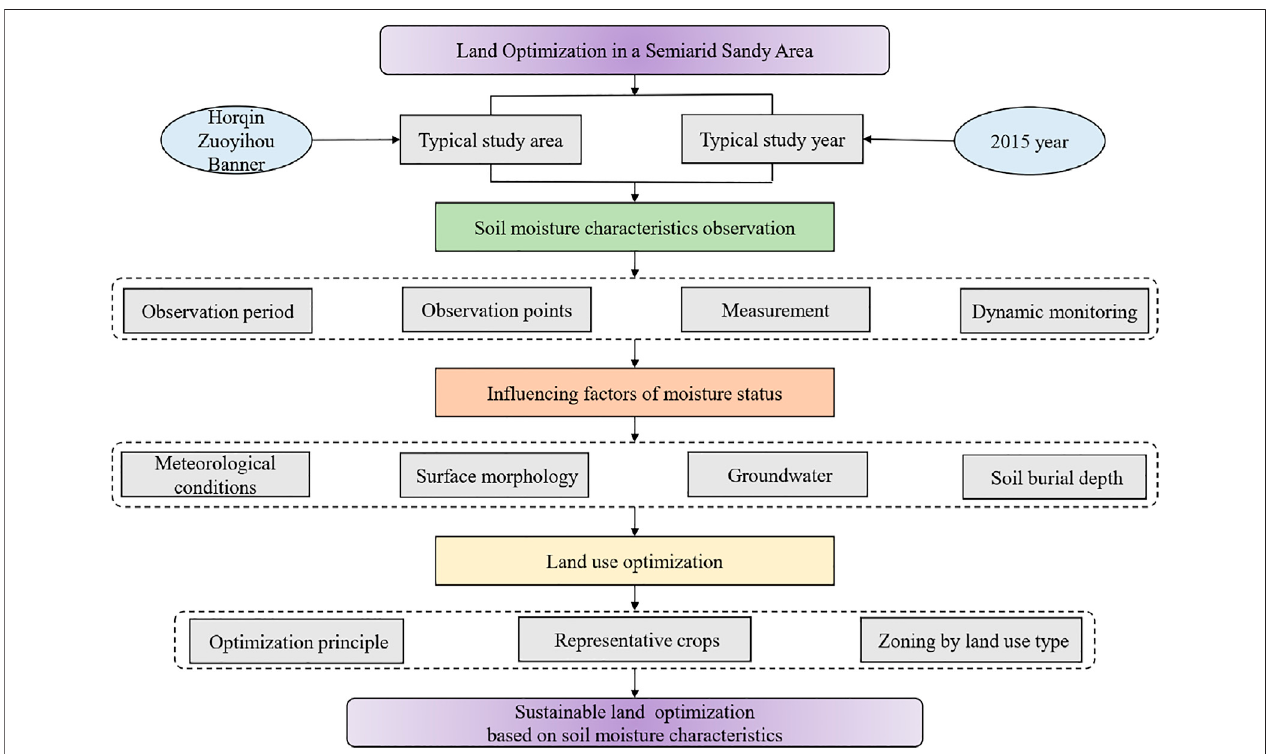
Frontiers in Environmental Science |